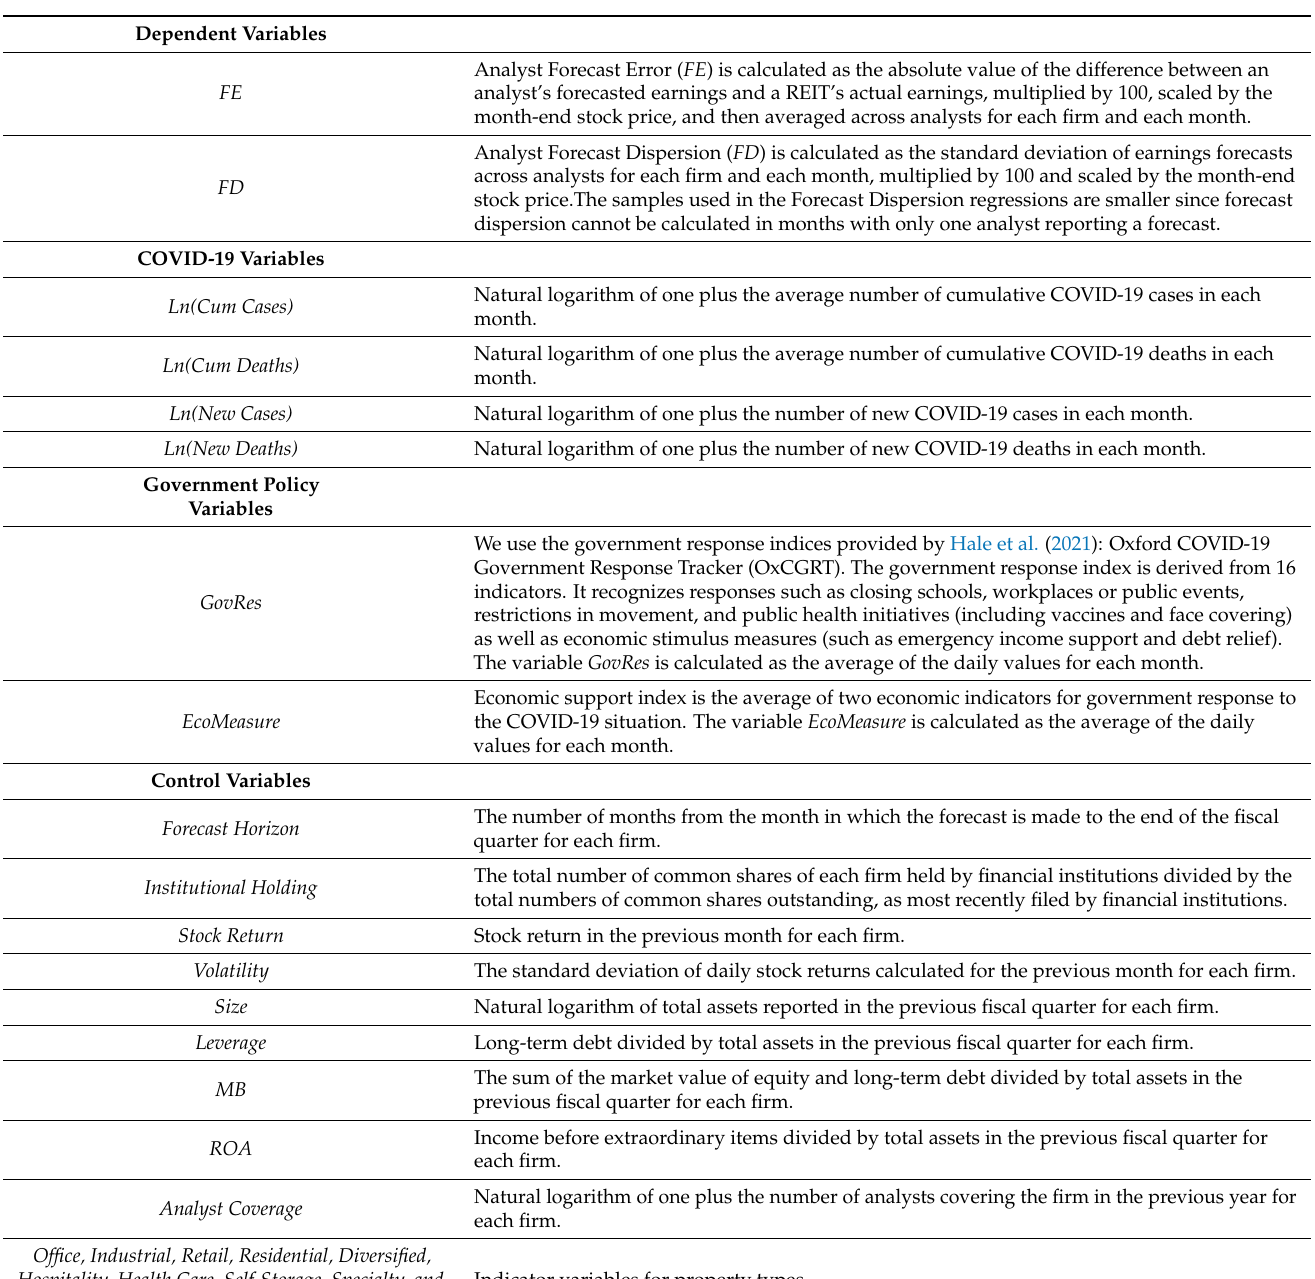
Table A1. Variable